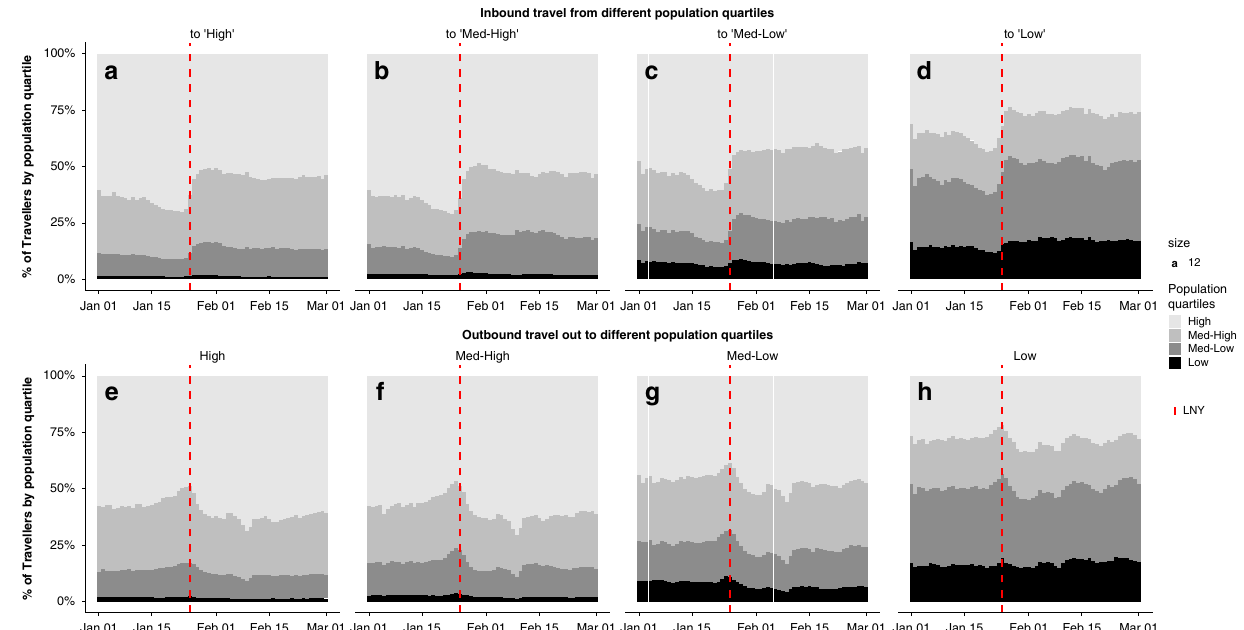
Fig. 2 Contribution of each population quartile to inbound and outbound travel. Shading marks the population quartile with highest population quartiles in the lightest shade. The red dashed line shows the fi rst day of LNY (25th January 2020). The fi gure displays the proportion of travel from all quartiles to High ( a ), Medium-high ( b ), Medium-low ( c ) and Low ( d ) population quartiles, as well as the proportion of travel to all quartiles originating from High ( e ), Medium-high ( f ), Medium-low ( g ) and Low ( h ) population